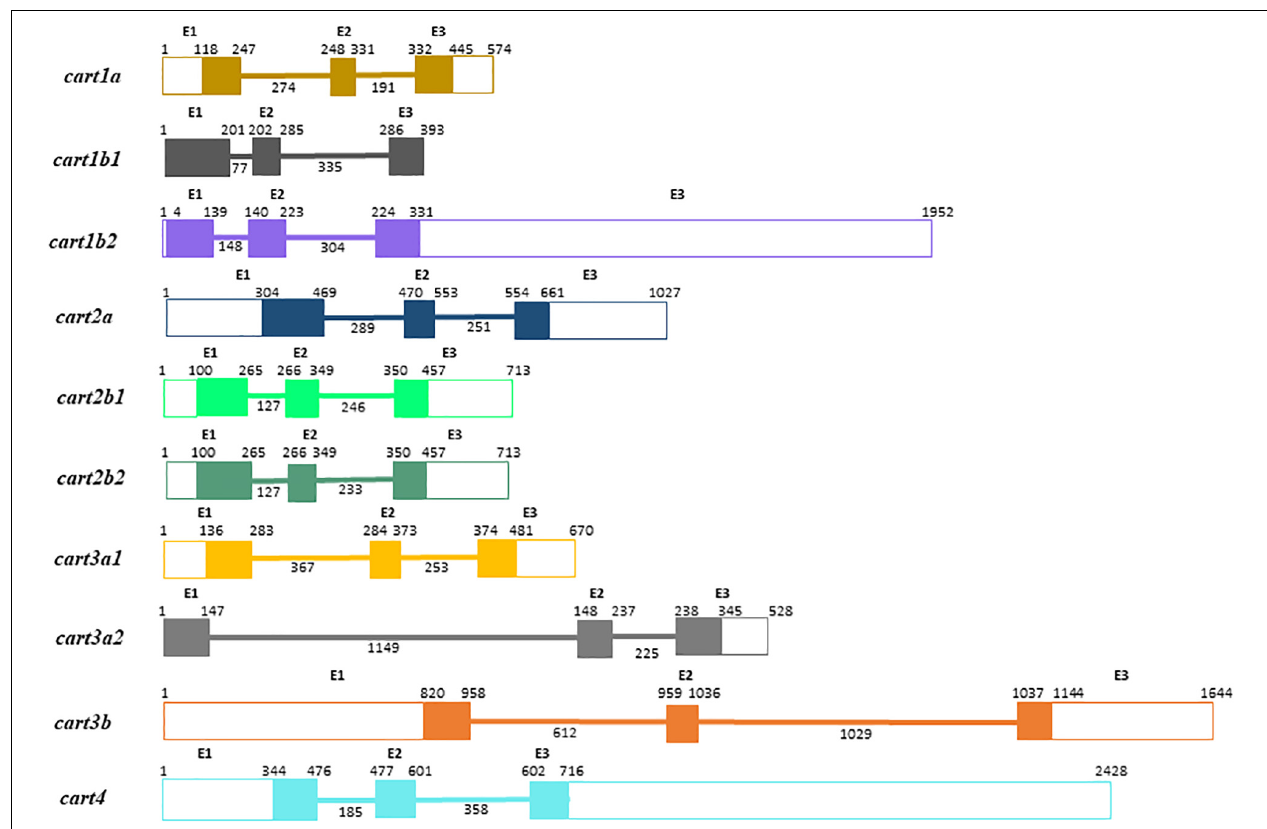
FIGURE 1 | Predicted gene structure of Atlantic salmon cart paralogs. Exons (E1–E3) are represented by boxes and connection lines indicate introns. The open reading frames (ORF) are indicated by filled boxes and untranslated regions (5 (cid:48) UTR and 3 (cid:48) UTR) by open boxes. Size of introns and exons (UTRs and ORFs) are given below the lines and above the boxes, respectively, in base pairs